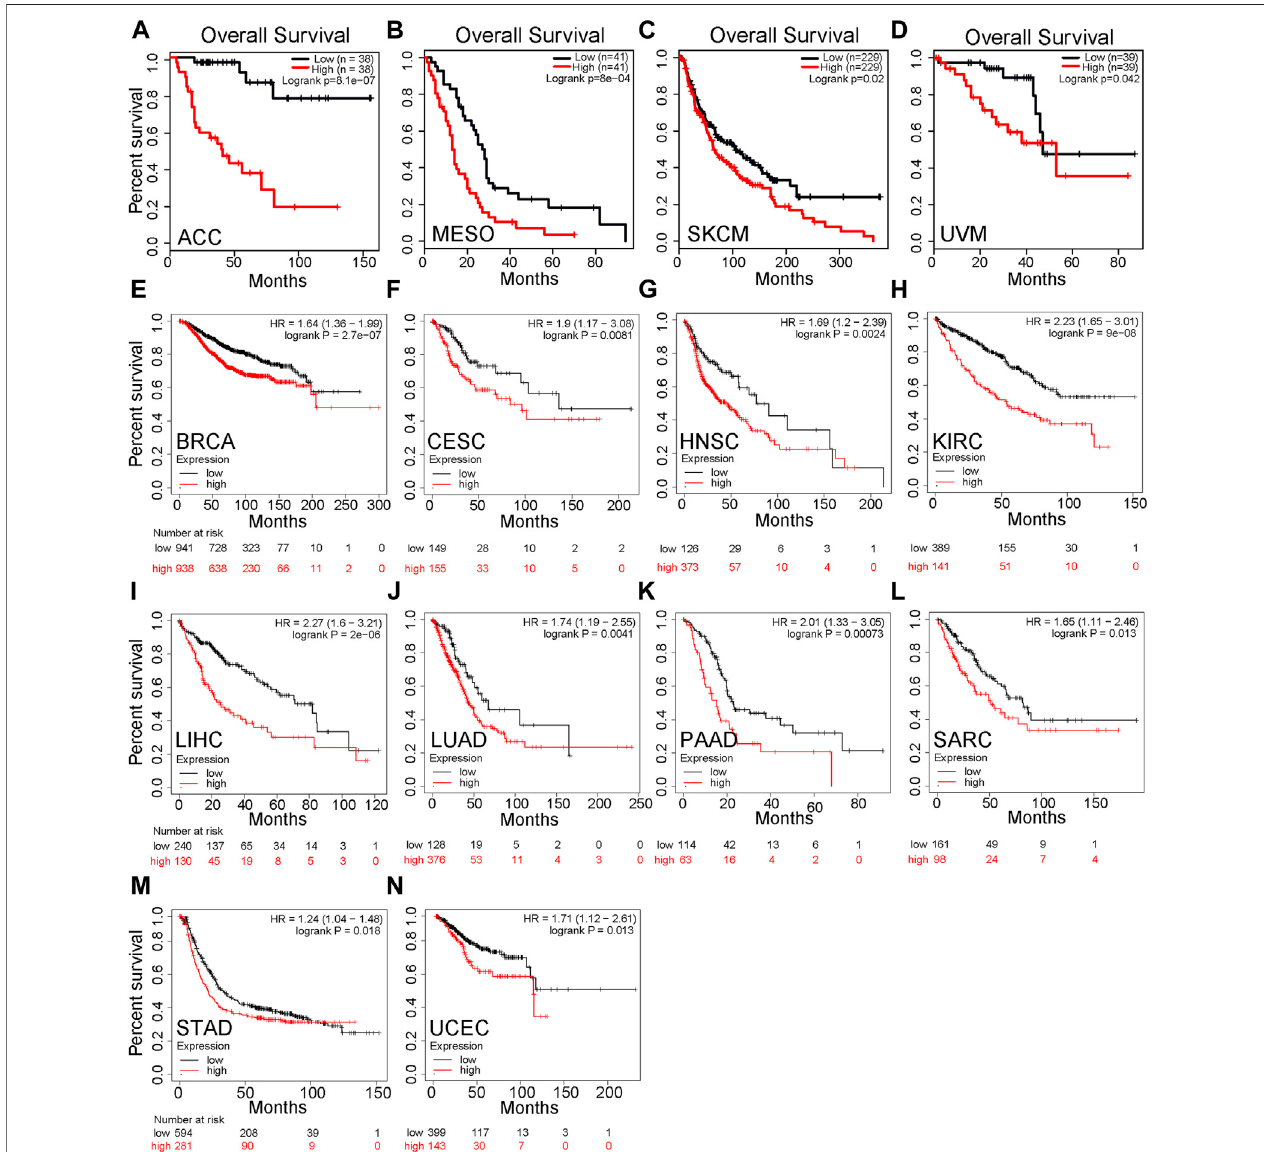
FIGURE 4 | Correlation between PPP1R14B gene expression and survival prognosis of cancers in TCGA. (A – D) PPP1R14B expression and the prognosis of patients with different tumors in the TCGA and GEO datasets in GEPIA2. (E – N) Analysis of survival data using the Kaplan – Meier plotter tool.